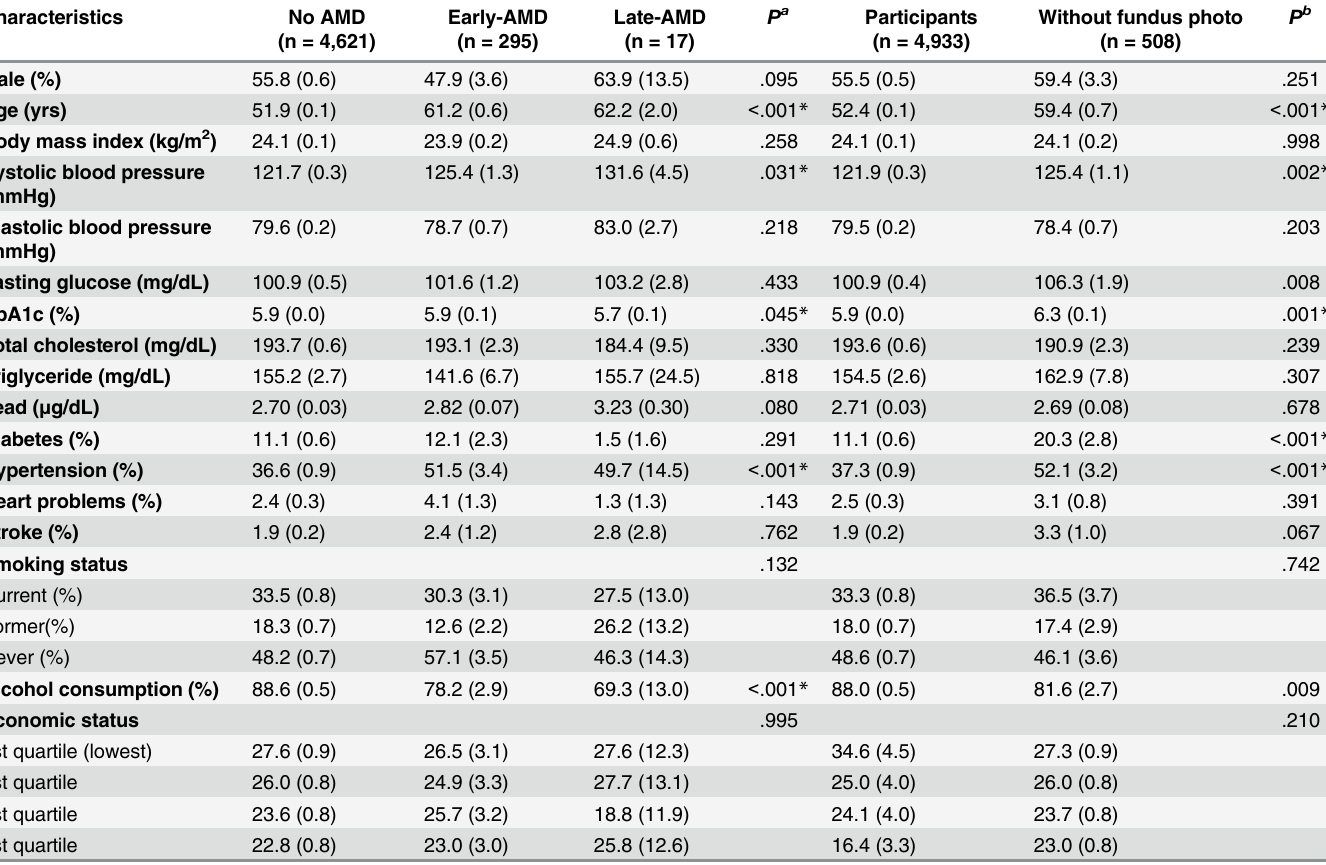
Table 1. Demographic and clinical characteristics according to early- and late- age-related macular degeneration (AMD) status, and participant status, as reported by the Korean National Health and Nutrition Examination Survey 2008 – 2012.